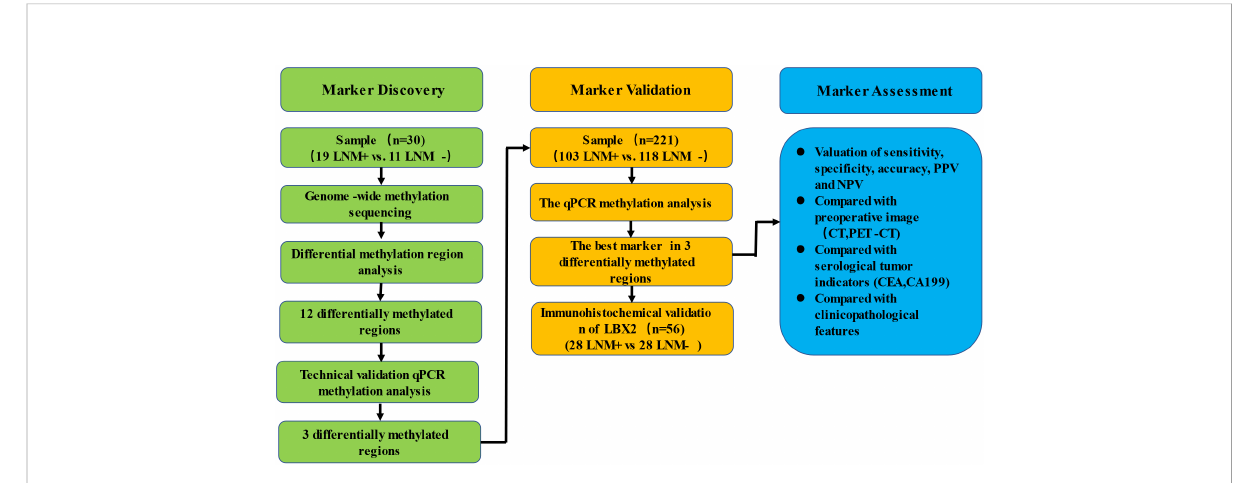
FIGURE 1 Schematic work fl ow of the study